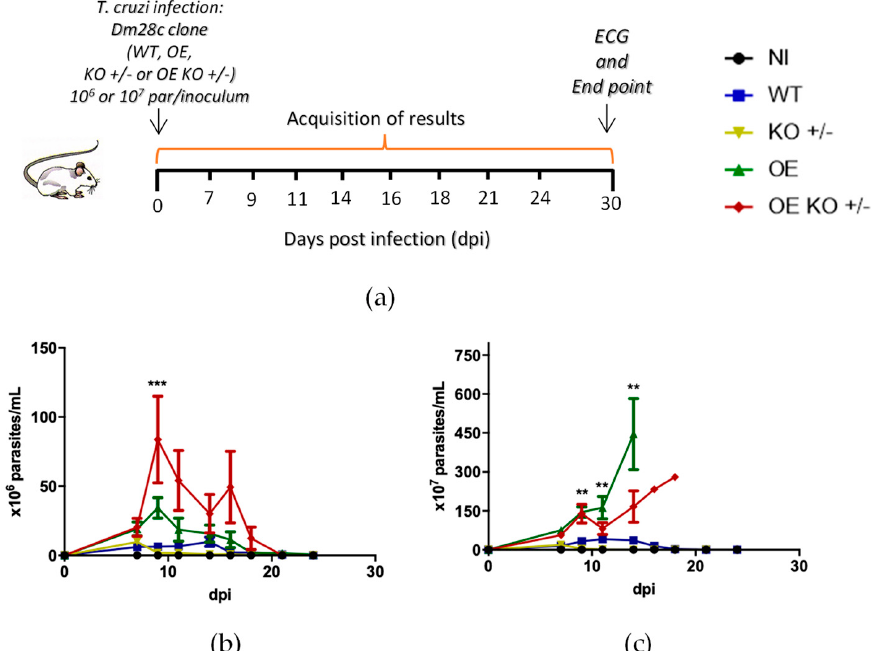
Figure 1. Experimental design and parasitological evaluation of extracellular forms of blood trypo- mastigotes from animals infected with T. cruzi hemi-knockout or overexpressing the TcNTPDase-1 gene. Mice non-infected (NI) or infected with (wild type) WT, (overexpressed) OE, (hemi-knockout) KO +/ − , and (overexpressed hemi-knockout) OE KO +/ − were followed up to 24 days after infection. ( a ) Experimental design of infection of Swiss male mice inoculated intraperitoneally with 10 6